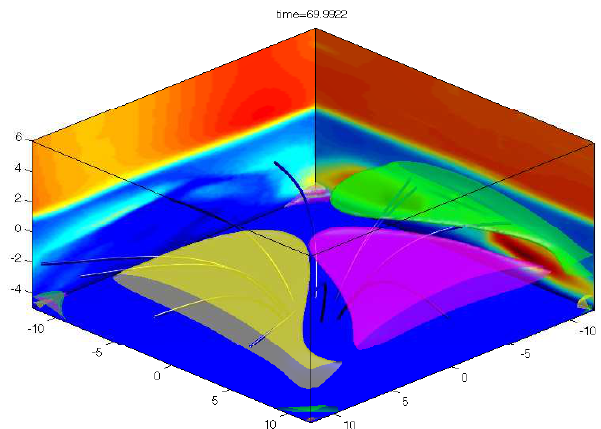
Fig. 2. Distribution of diamagnetic cavity position as indicated by high β region of cusp for strongly northward (green), purely + B y (magenta), and strongly southward IMF IMF